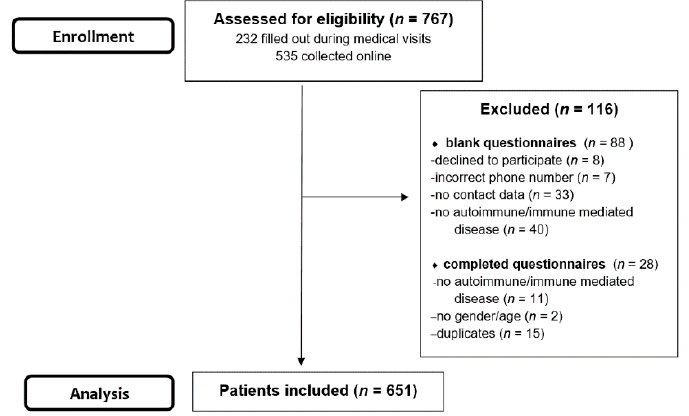
Figure 1. Patient’s selection flow diagram .